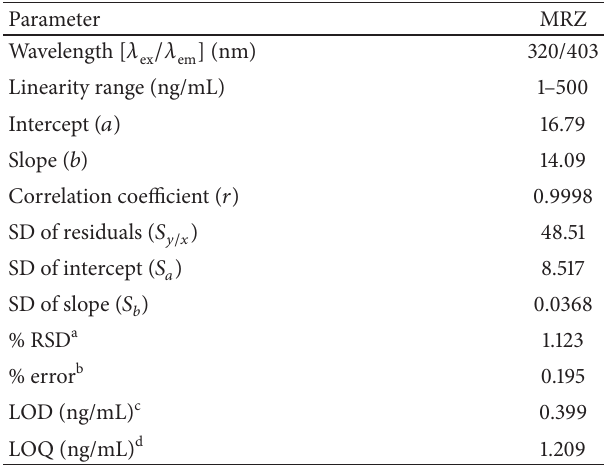
a Percentage relative standard deviation for three replicate samples. b Percentage relative error for three replicate samples. c Limit of detection. d Limit of